Question: According to the figure, is the described quantity increasing or decreasing?
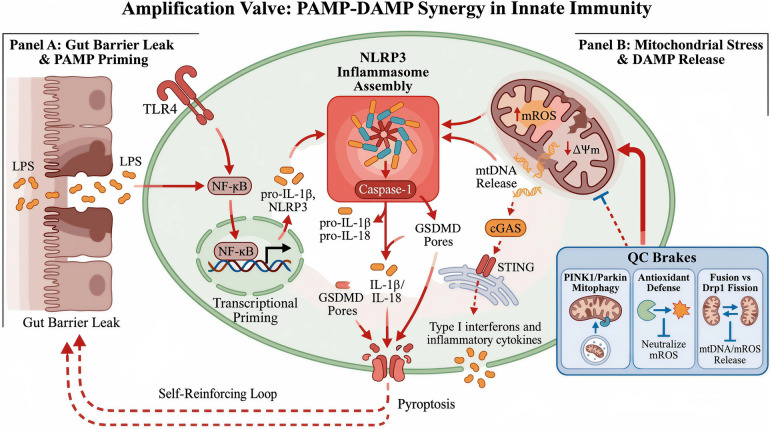
Answer: increasing